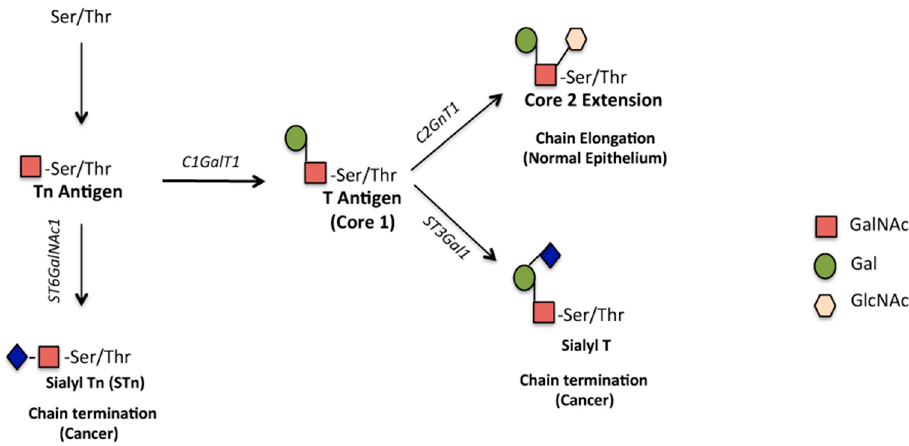
Figure 2. Schematic representation of O -Linked glycan biosynthesis